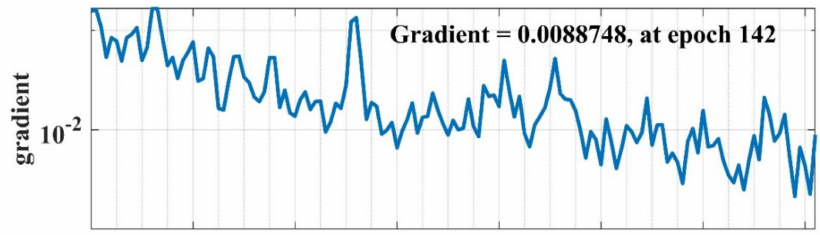
Figure 22. NN gradient search method learning curve w.r.t. number of epochs.